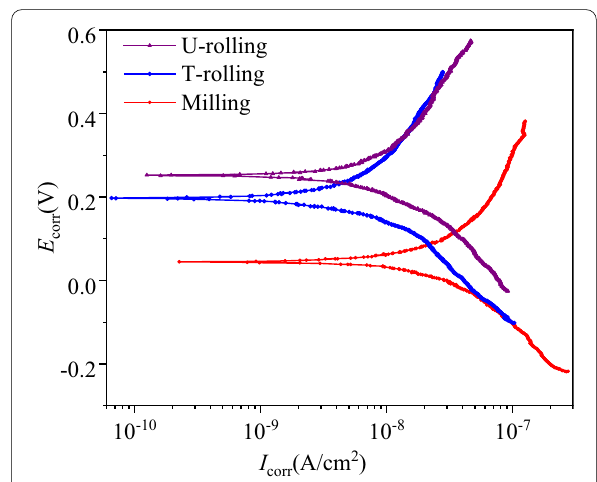
Figure 7 Potentiodynamic polarization curves for different samples